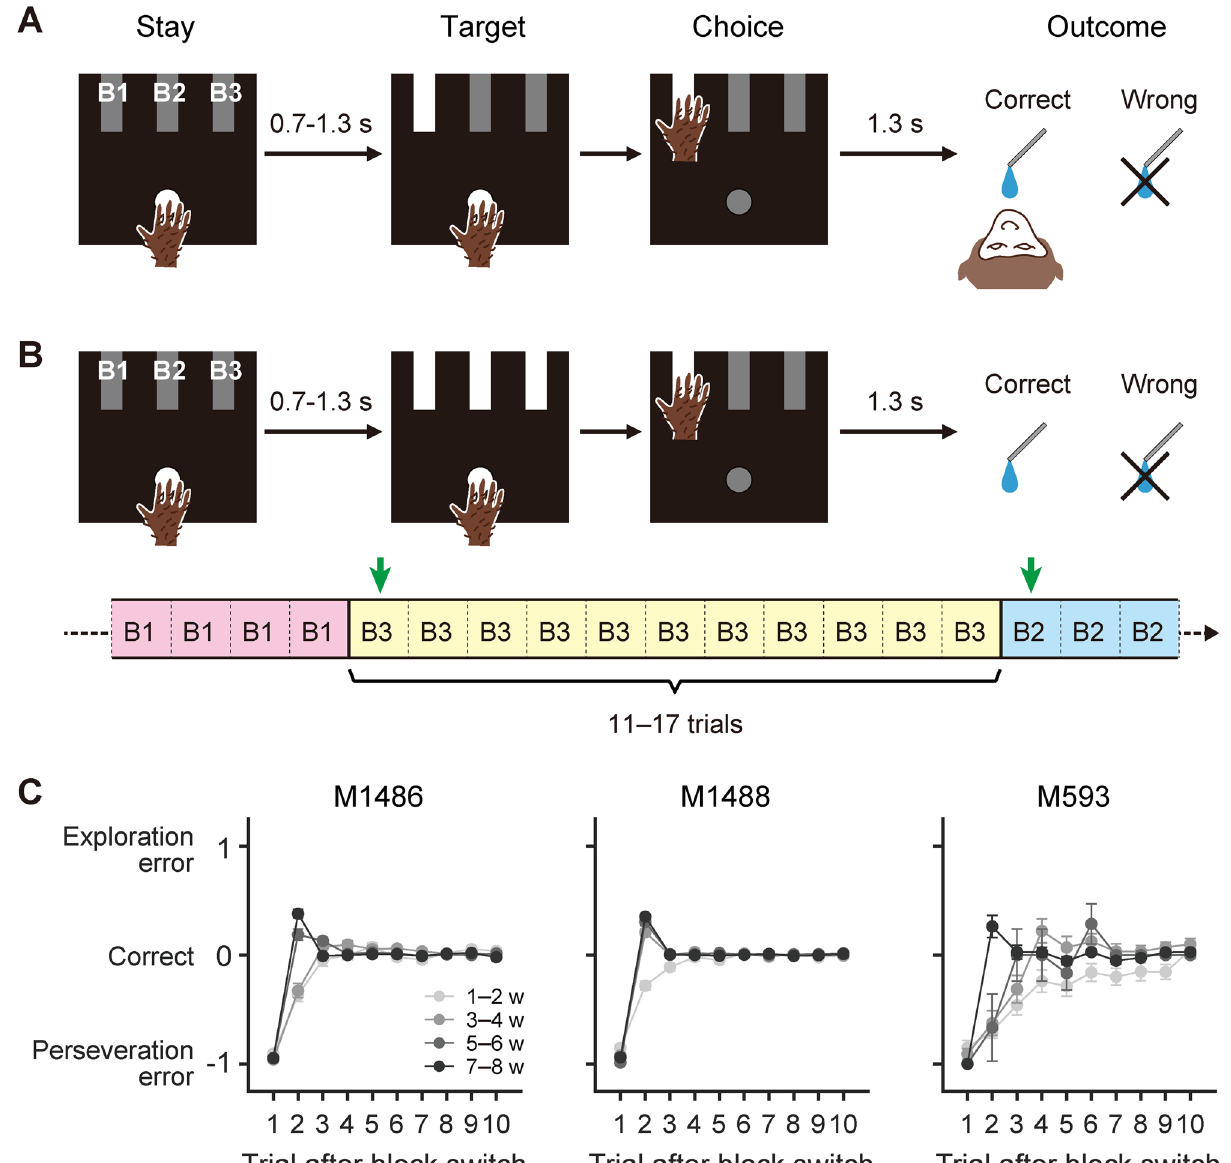
Figure 1. Behavioral procedures in non-social task condition for M593. ( A ) Sequence of events in visually- guided reaching task. ( B ) Sequence of events in non-social reversal learning task. The correct target was switched after every 11–17 trials without prior notice. Green arrows indicate switch trials. ( C ) Performance score in each trial after block switches. Mean ± SEM in Trial 1 (i.e., switch trial). Data are shown separately for different training phases. A score of − 1 was assigned when monkeys selected a target that was correct in the preceding block (perseveration error). A score of 0 was assigned when monkeys selected the correct target in the current block. A score of + 1 was assigned when monkeys selected a target that was incorrect in the previous and current blocks (exploration selectively or preferentially to the partner-action (“Methods” for the definition of neuronal classification). In these neurons, the magnitude and latency of response to the action-target stimuli were not systematically differ- ent between M593 and its control monkeys (Fig. S2). However, the matrix obtained from principal component analysis revealed that M593 occupied distant positions in the principal space (Fig. S3A). We found that the pro- portion of mirror-type neurons among the total actor-related neurons was significantly lower in M593 compared to the control monkeys (Tables 1 and 2). The lower proportion of mirror-type neurons was confirmed in both PMv (Table 1; M593 vs. M1486, P = 0.004; M593 vs. M1488, P = 0.037; chi-square test) and MPFC (Table 2; M593 vs. M1486, P = 0.037; M593 vs. M1488, P = 0.038; chi-square test). For these neurons, the magnitude of response modulation was not significantly different between M593 and the control monkeys in either the PMv (Fig. S4A; self-action, P = 0.089; partner-action, P = 0.29; two-tailed Welch’s t -test) or MPFC (Fig. S4B; self-action, P = 0.34; partner-action, P = 0.28; two-tailed Welch’s t -test). In the PMv, the proportion of self-type neurons was greater